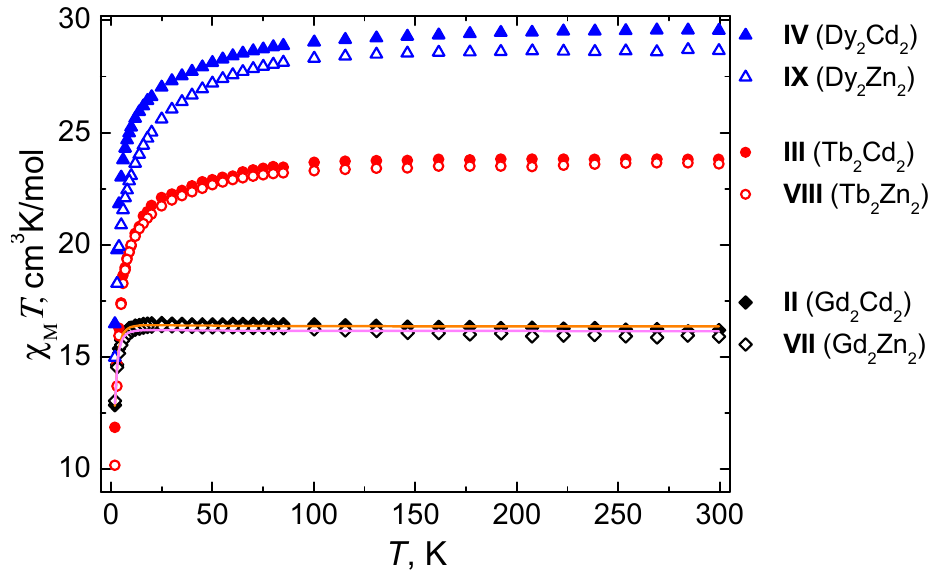
Figure 9. The χ M T vs. T dependencies for complexes II–IV (calculated per Ln 2 Cd 2 unit) and VII–IX under 5000 Oe dc-magnetic field. Solid lines are the best-fit curves obtained for complexes II and VII using PHI program [43]. Table 4. The χ M T values of II–IV (calculated per Ln 2 Cd 2 unit), VII–IX.